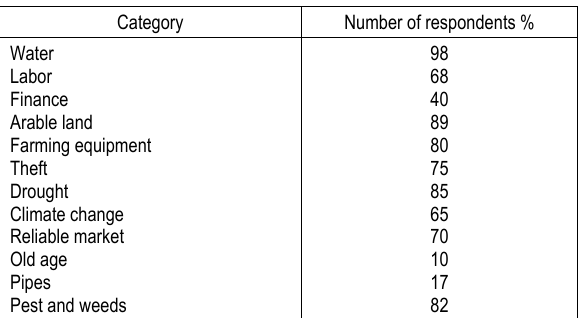
Table 4. Challenges faced by